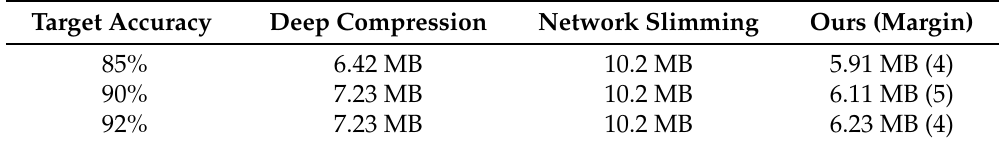
Table 2. The sizes of the minimized models in the corresponding accuracies derived from the proposed method and the individual cases of network slimming and deep compression for VGG-19.